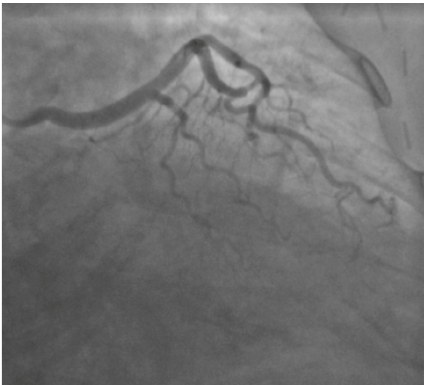
Figure 1: RAO caudal view showing absent left circumflex (LCX) and long left main coronary artery.